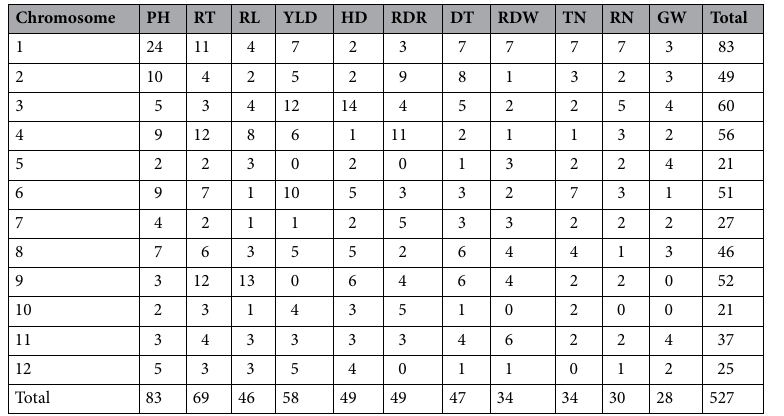
Table 2. The number of initial QTLs on the 12 chromosomes of rice for YLD, GW, HD, PH, TN, DT, RT, RL, RDR, RDW and RN traits under water deficit condition used for MQTL analysis after integrating into the reference map. YLD yield, GW grain weight, PH plant height, HD heading date, TN tiller number, DT drought tolerance, RDW root dry weight, RL root length, RN root number, RT root thickness, RDR ratio of deep